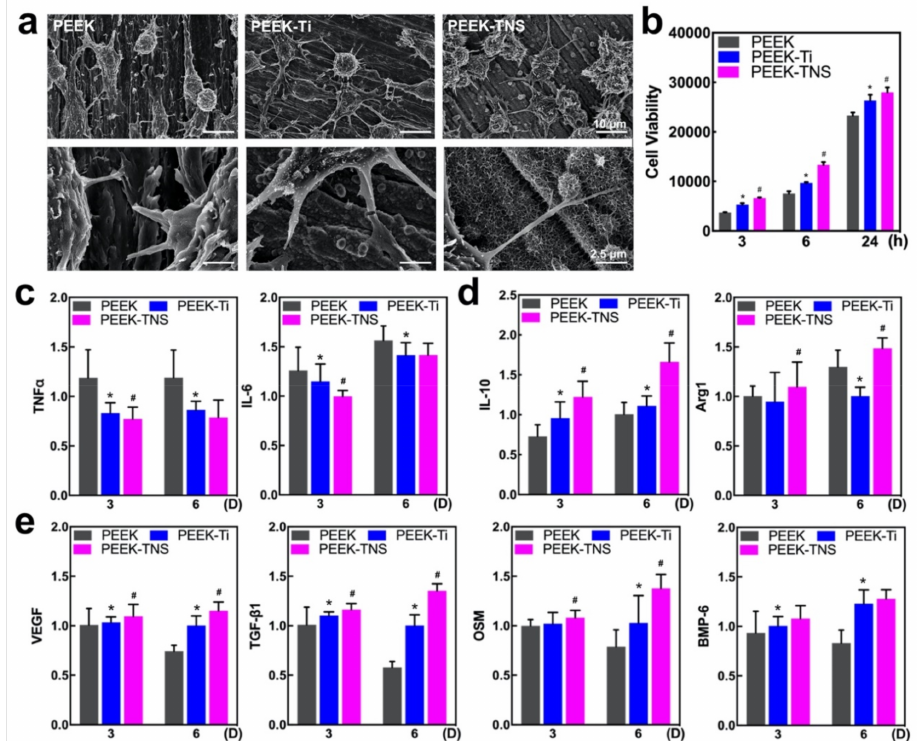
Figure 3. The immune response of RAW 264.7 on different samples of PEEK, PEEK-Ti, and PEEK-TNS, scale bar = 10, 2.5 µ m. ( a ) SEM images illustrating cell growth and morphology of RAW 264.7. ( b ) Cell proliferation for 3, 6, and 24 h. ( c ) RT-qPCR of the M1-related genes expressions. ( d ) RT-qPCR of the M2-related genes expressions. ( e ) RT-qPCR of the osteogenic-related gene expressions. (* represents p < 0.05 when PEEK-Ti is compared with PEEK; # represents p < 0.05 when PEEK-TNS is compared with